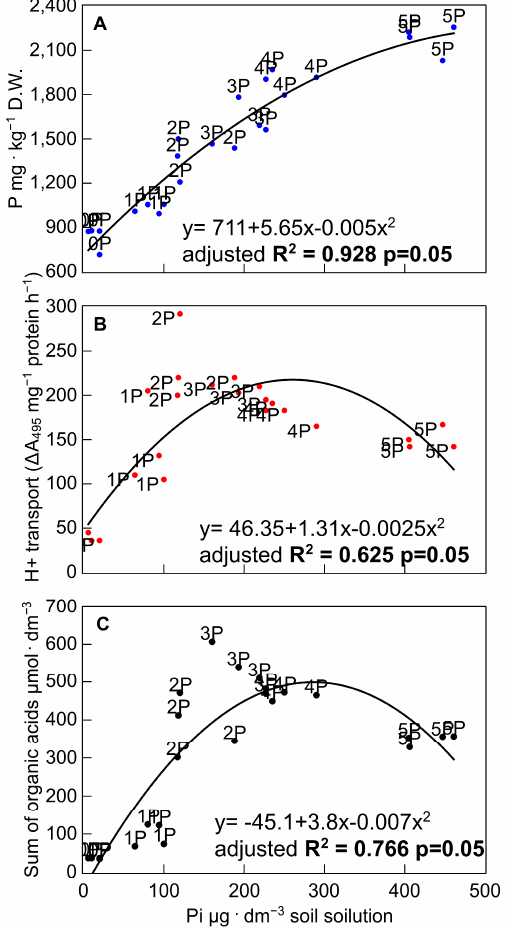
Figure 8. Correlation analysis between P concentration in shoots ( A ), H + -ATPase-driven proton efflux ( B ), and OA exudation ( C ) and the P concentration in soil solution from pots in which rye varieties were grown on the post-flotation sediment under 0 (0P), 22 (1P), 44 (2P), 66 (3P), 88 (4P), and 110 (5P) mg P · kg − 1 . The coefficients of determination ( R 2 ) and curve fitting were determined using the data from all treatments ( p < 0.05) with QtiPlot 1.0.0-rc13